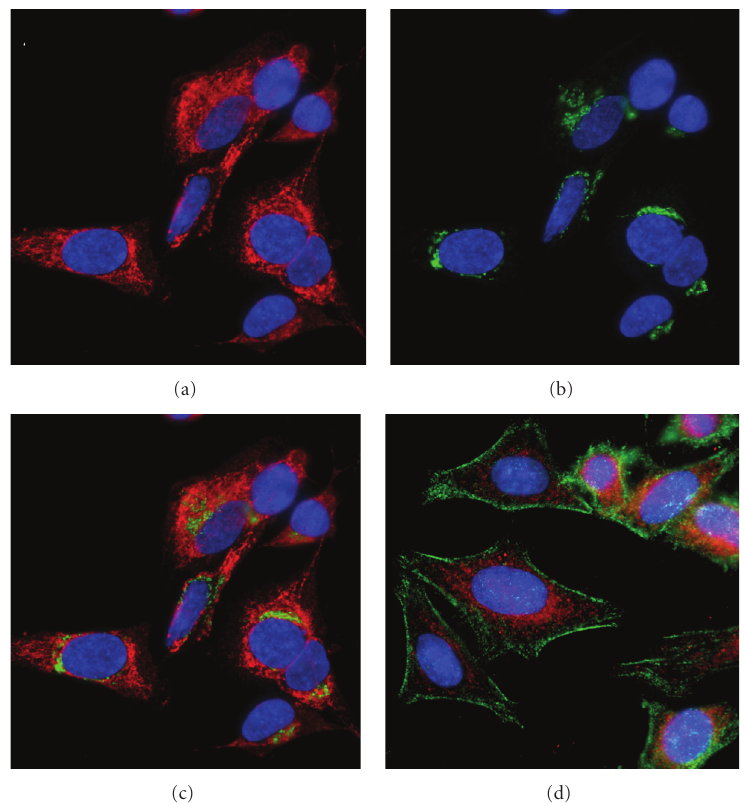
Figure 4: Confocal imaging of HeLa cells stained with antibodies against TOM1L (red) and anti-trans-Golgi network. Individual images were separated digitally: (a) anti-TOM1L (red), (b) anti-trans-Golgi network (green), and merged images (c). (d) HeLa cells stained with anti-TOM1L (red) and anti-Cathepsin D antibodies (green). Cells were stained with DAPI (blue) to visualize the localization of the